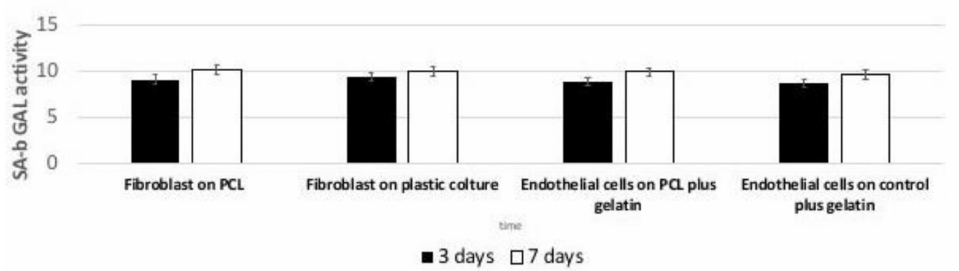
Figure 8. Evaluation of Senescence-associated beta-galactosidase (SA-b GAL) activity of Fibroblast or endothelial cells. Results show that cells cultured on PCL, PCL plus gelatin, plastic cultures, plastic cultures plus gelatin have similar SA-b GAL activity value.